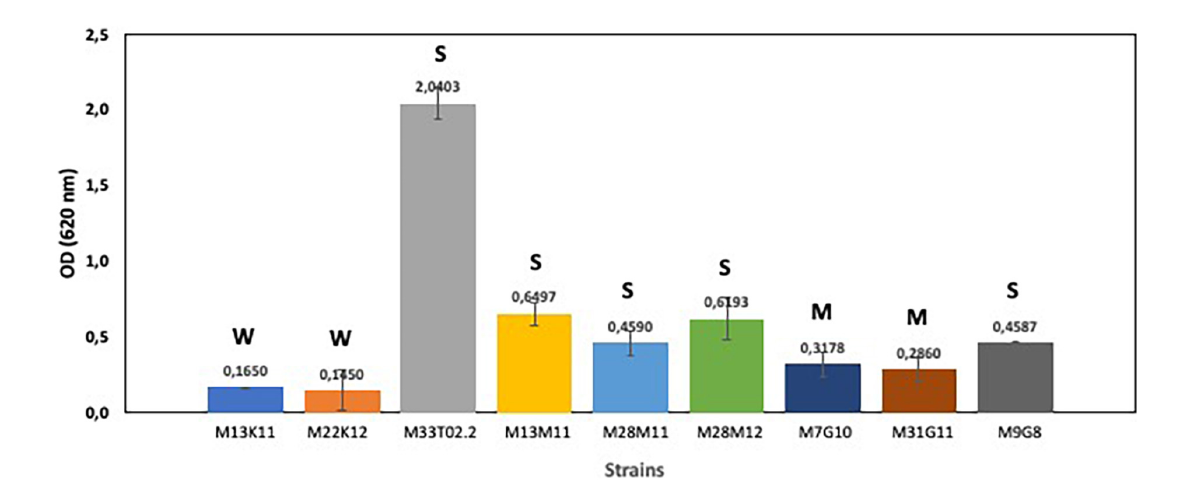
FIGURE1 Biofilm formation capacity of Enterococcus sp. strains M13M11, M28M11 and M28M12; Staphylococcus sp. strains M7G10, M9G8 and M31G11; and Pseudomonas sp. strains M13K11, M22K12 and M33T02.2. Data were expressed as mean value ( ± standard deviations). The cut-off (ODC) was defined as the mean OD value of the negative control. Based on the OD, strains were classified as non-biofilm “N” producers (OD ≤ OD C ), weak “W” (OD C < OD ≤ 2 × ODC), moderate “M” (2 × OD C < OD ≤ 4 × OD C ) or strong “S” biofilm producers (4 × OD C < OD) according to Borges et al.